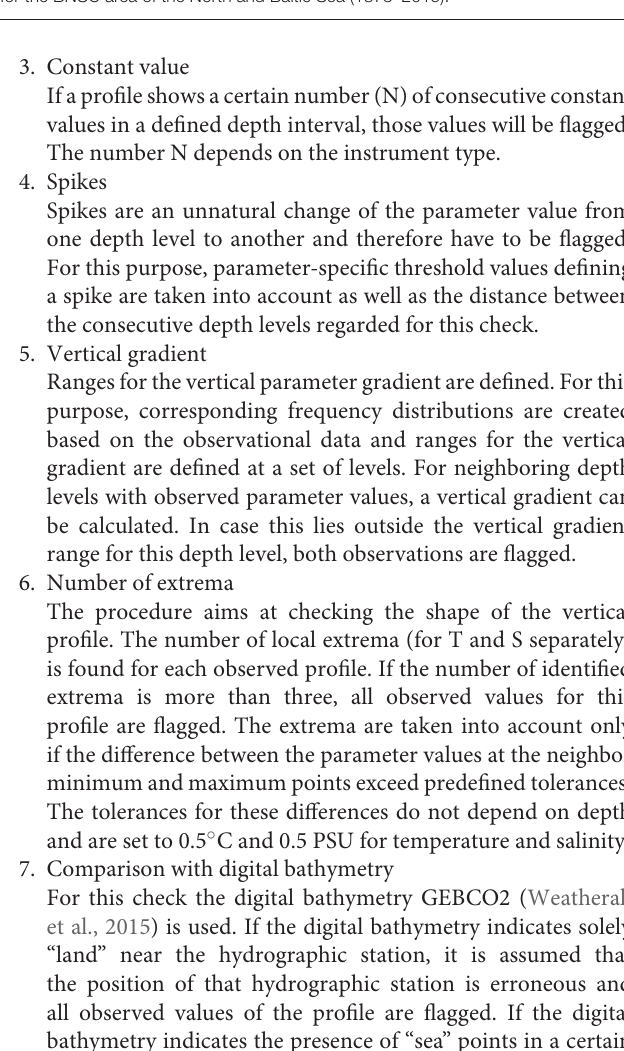
FIGURE 1 | Annual (A) and monthly (B) frequency of marine observational profiles for the BNSC area of the North and Baltic Sea